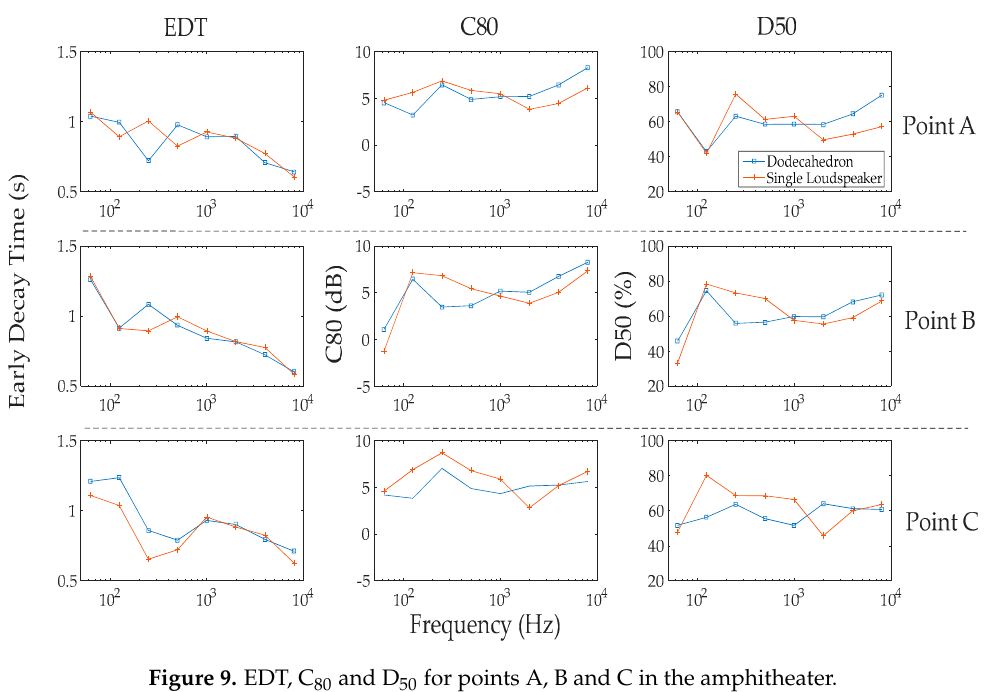
Figure 9. EDT, C 80 and D 50 for points A, B and C in the amphitheater.